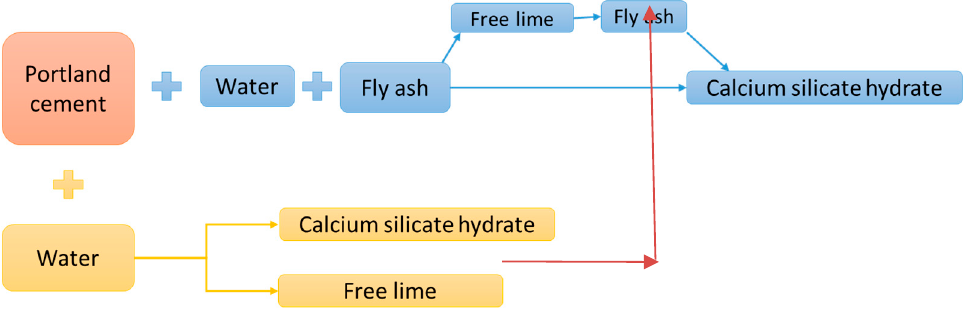
Figure 5. Reaction of fly ash (FA) in cement [70].